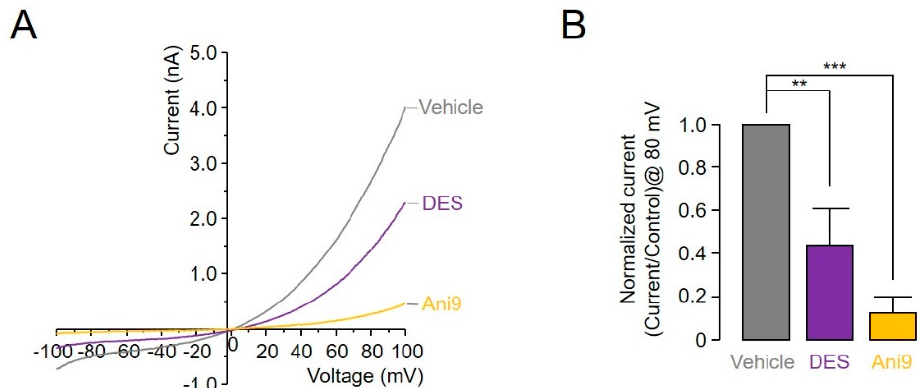
Figure 3. DES and Ani9 inhibit ANO1-induced currents in ANO1-expressing HEK293 cells. ( A ) Current/voltage (I/V) plot of mean currents. ( B ) Bar graph summarizing current densities measured at +80 mV (mean ± S.D., n = 5–8). ** p < 0.01, *** p < 0.001, Students’ unpaired t -test.